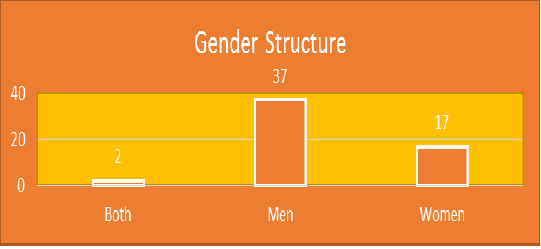
Figure 7 . gender analysis and population